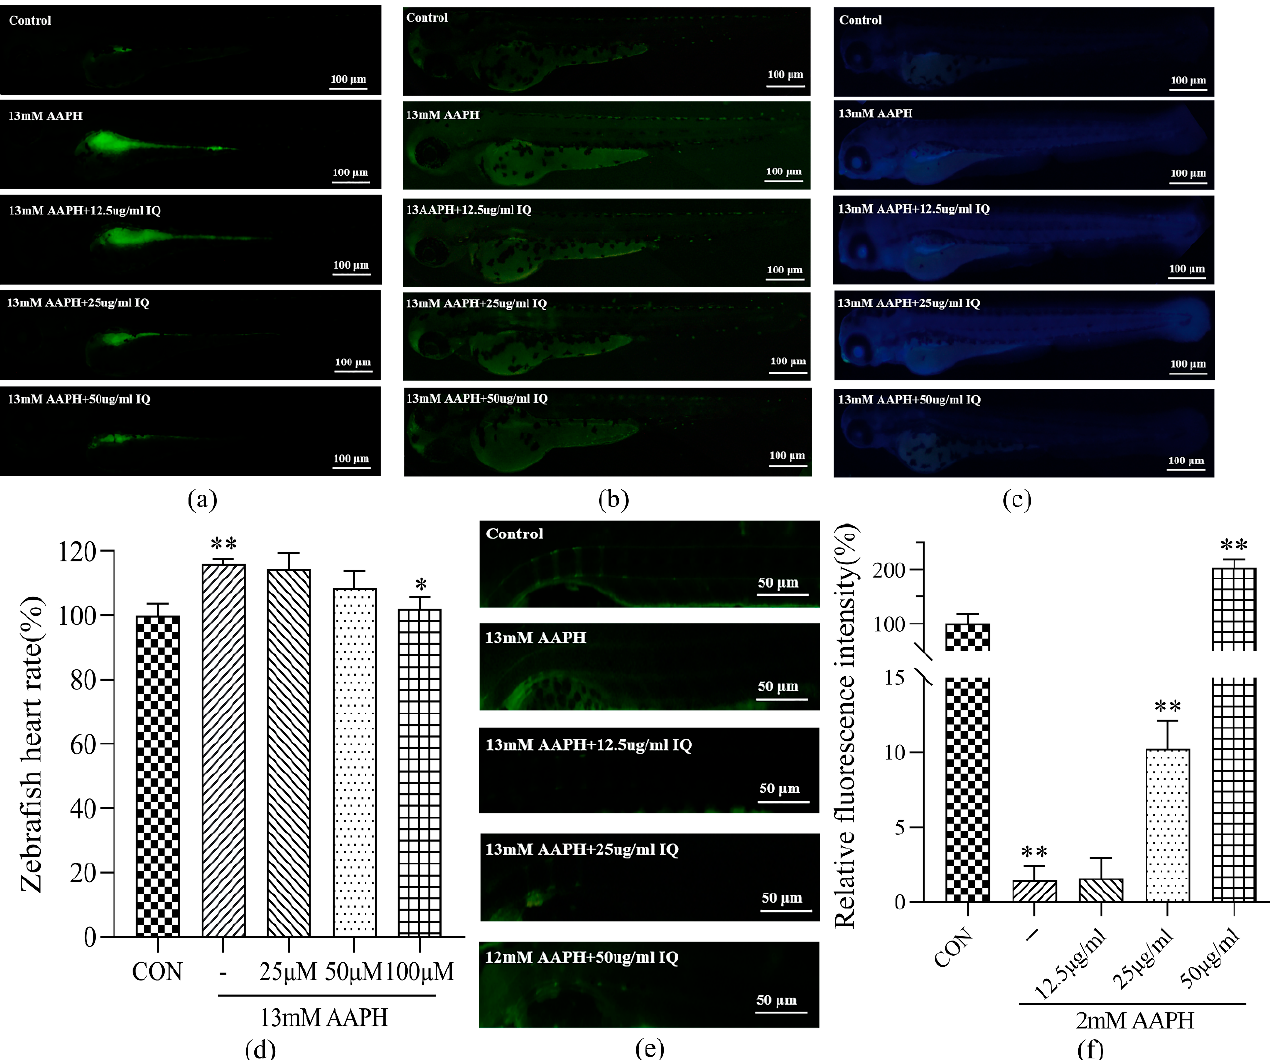
Figure 4. Effect of IQ on AAPH-induced antioxidant and injury repair of zebrafish. ( a ) ROS staining experiment of 72 hpf zebrafish; ( b ) apoptotic cell staining experiment of 72 hpf zebrafish; ( c ) lipid peroxidation staining experiment of 72 hpf zebrafish; ( d ) heart rate measurement of zebrafish; ( e ) staining experiment of 9 dpf zebrafish osteogenesis; ( f ) fluorescence intensity analysis of spine mineralization in 9 dpf zebrafish. Experiments were performed in triplicate, and the data were expressed as the mean ± SD, * p < 0.05, ** p < 0.01.